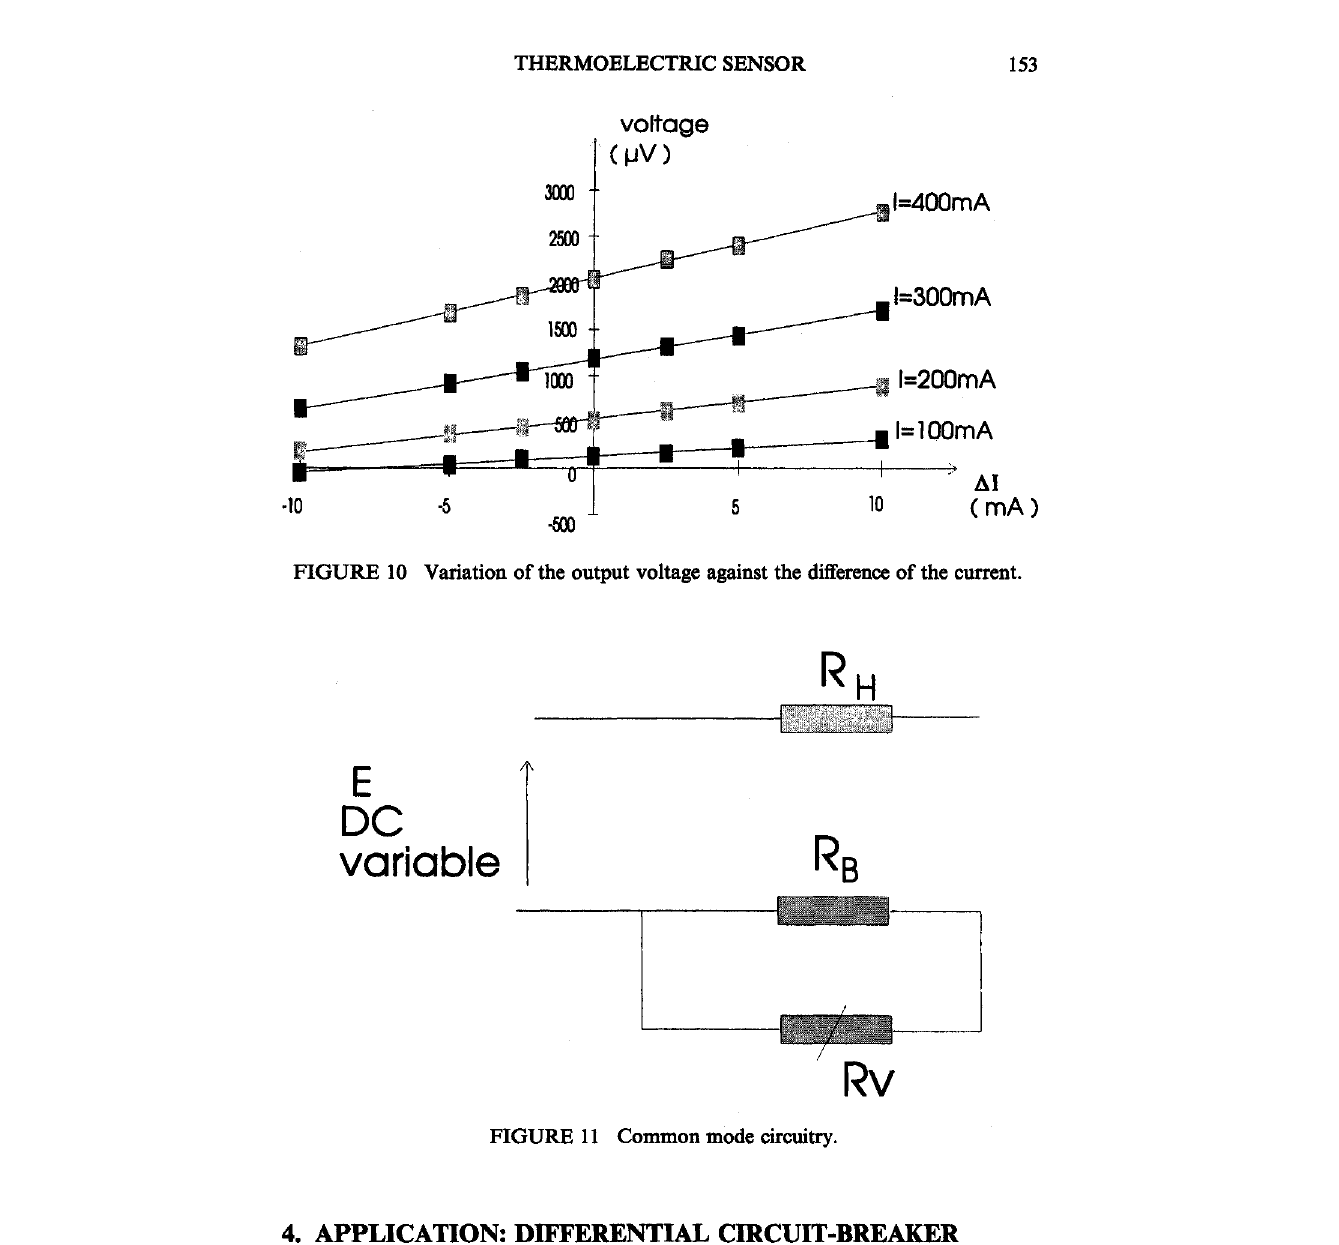
FIGURE 11 Common mode